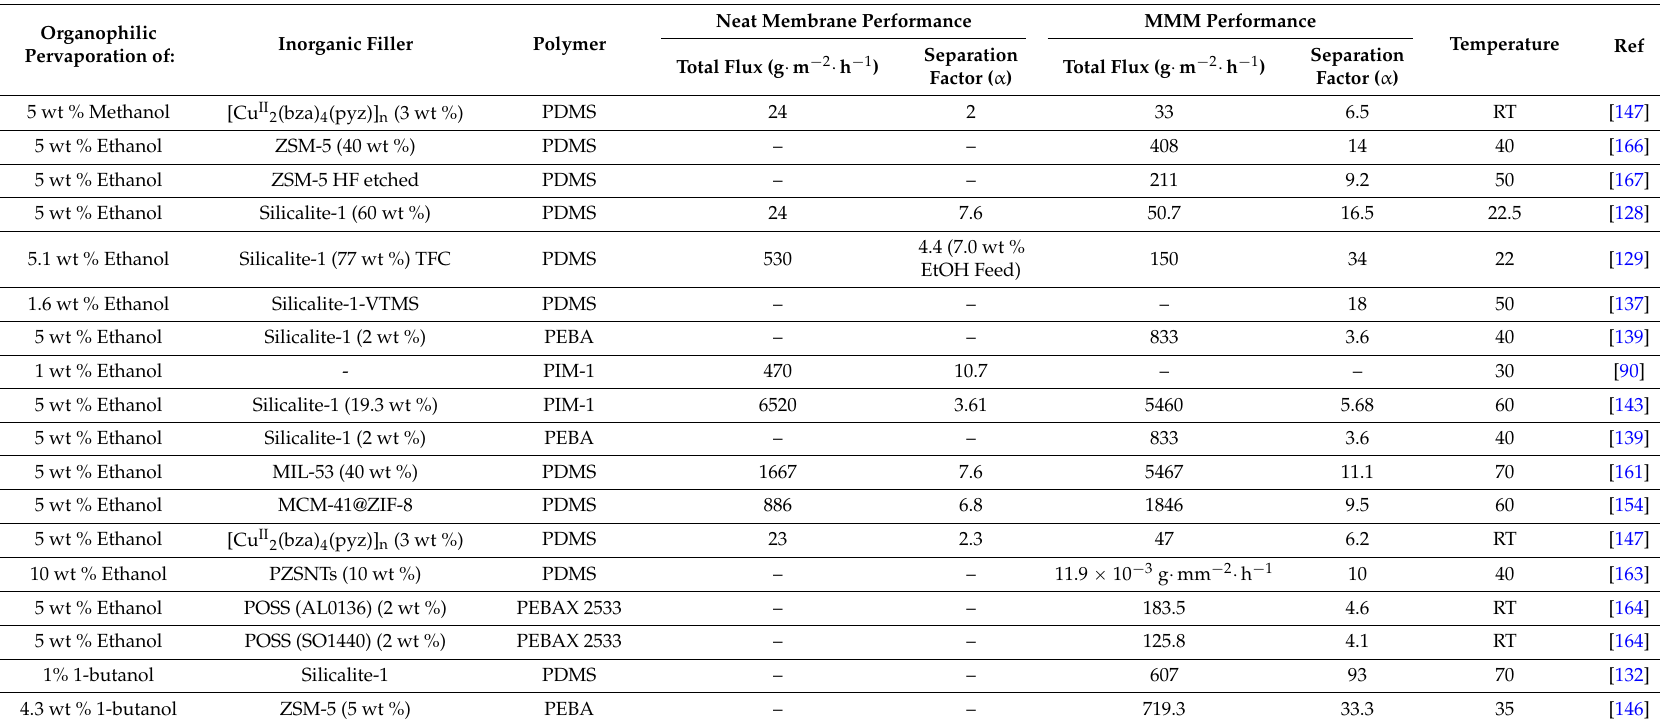
Table 5. Examples of MMMs for hydrophobic